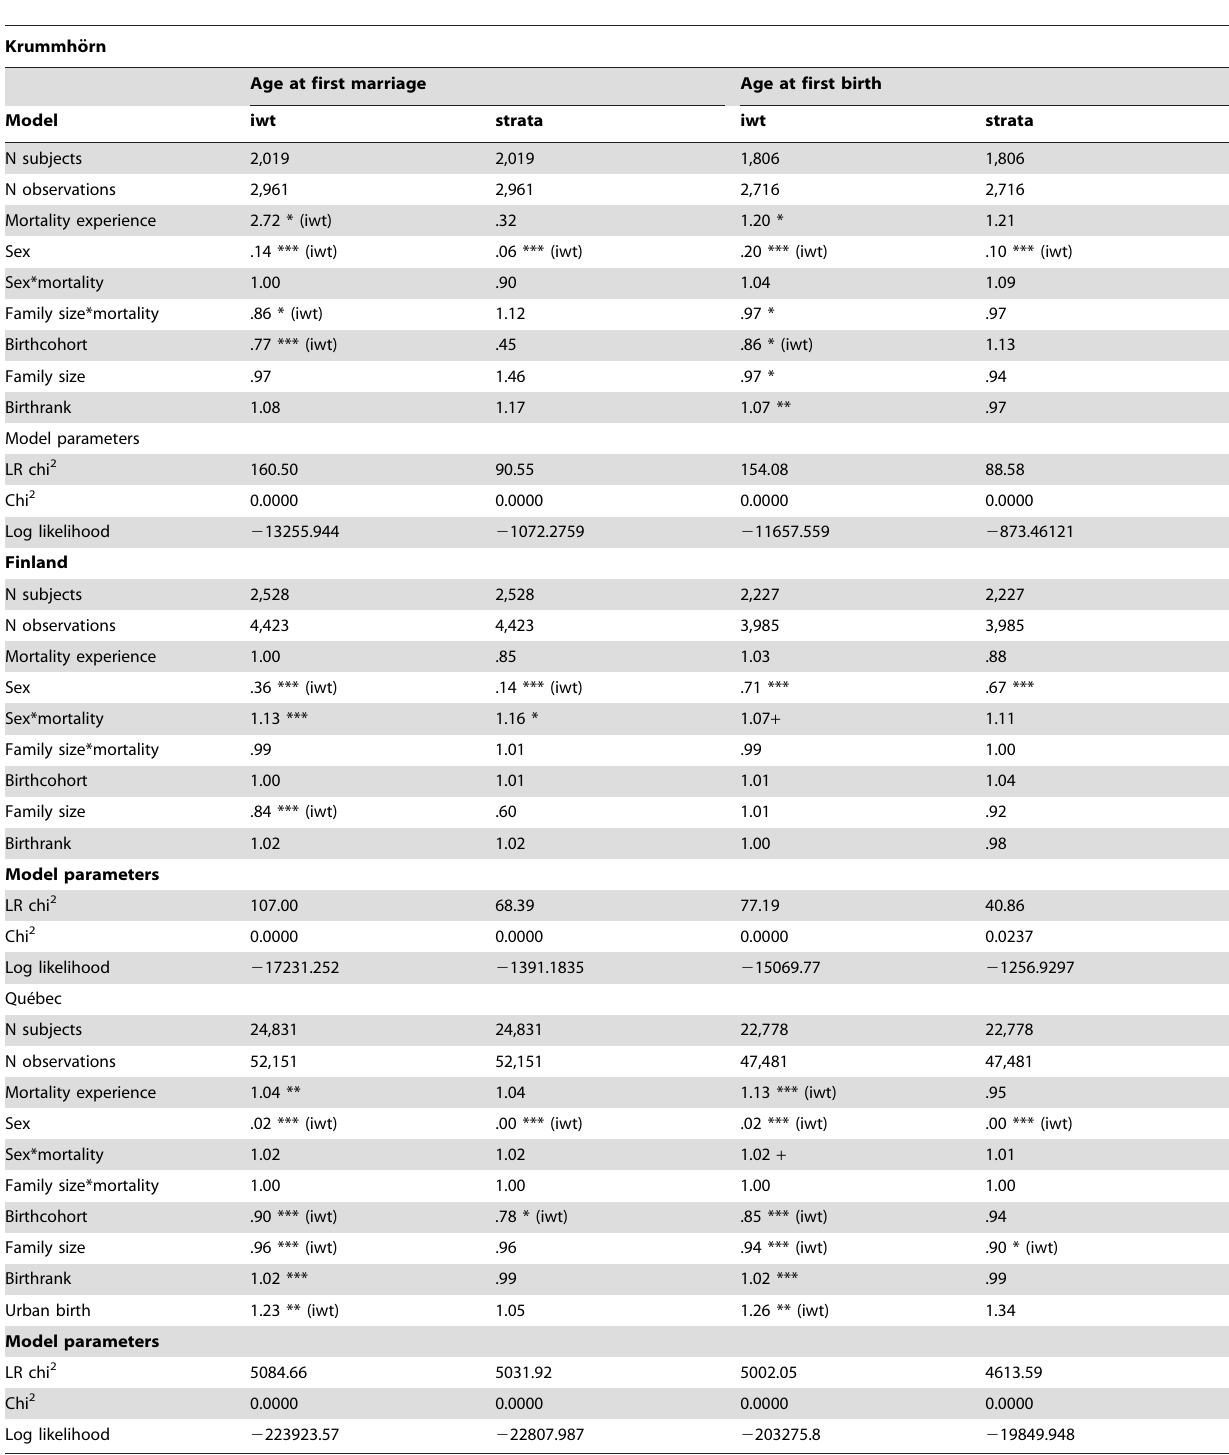
Results are shown for both the iwt-models (controlling for covariates showing an interaction with time if the proportionality assumption is not met) and the stratified model (stratification by family ID to control for family membership). The effects of the included covariates are reported as hazard ratios (HR). Sex is coded as 0= female and 1= male. For complete results of the models including all covariates see the supporting information (tables S1, S2 and S3). iwt = controlling for covariates showing an interaction with time. Significance: *** p , 0.001; ** p , 0.01; * p , 0.05; + p , 0.1.